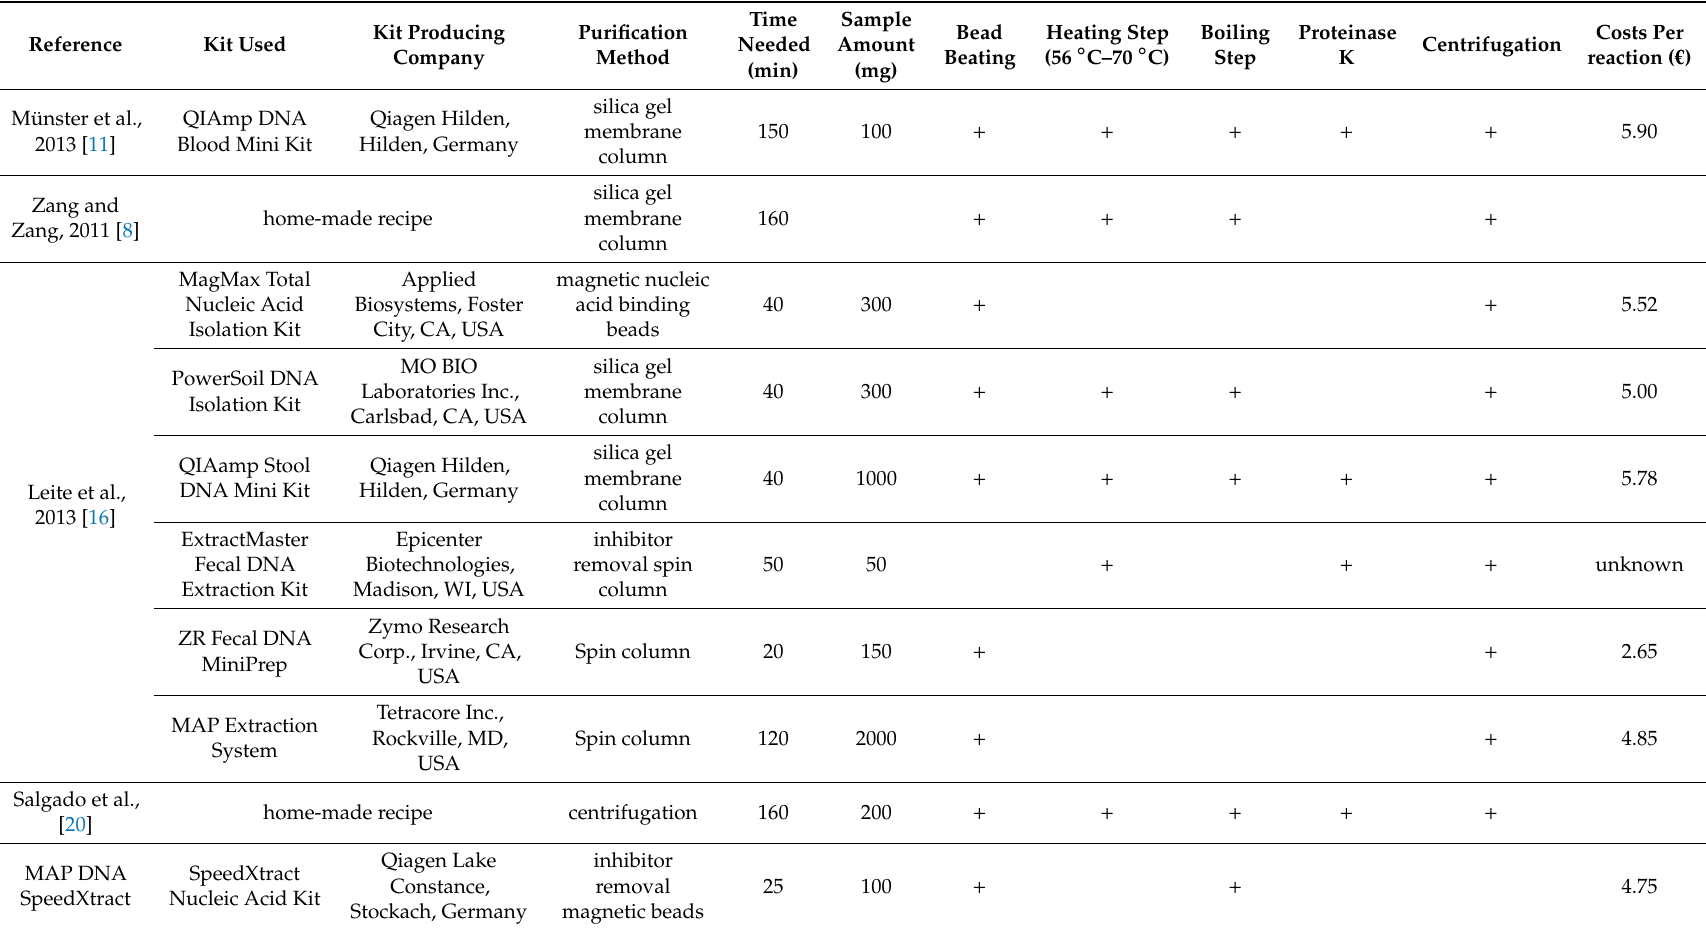
Table 2. Comparison between di ff erent published extraction protocols. + is employed in the respective